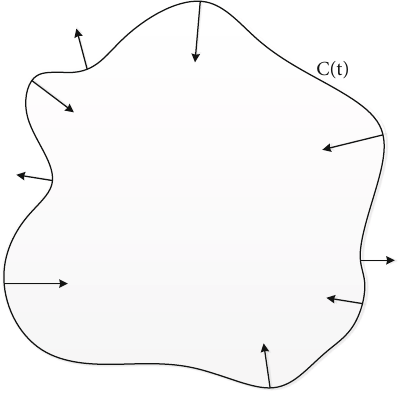
Figure 1: Curve evolution